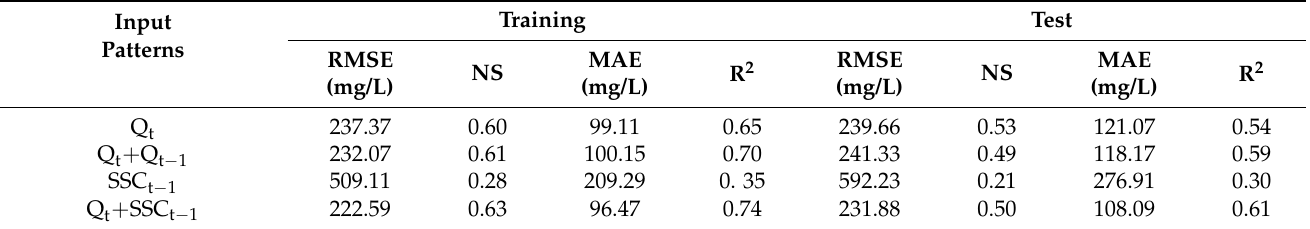
Table 6. Results of monthly SSC modeling by ANFIS with different input patterns during training and test